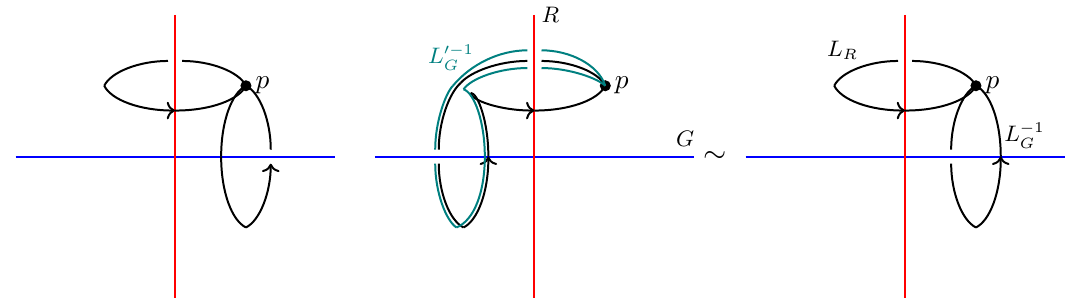
Figure 5 . Left two paths denote the possible paths of a D3 probe confined to a disk encircling the intersection of the two 7-brane stacks. The homotopy relation between the right two paths allows one to conclude the monodromy acting on the homology of the elliptic